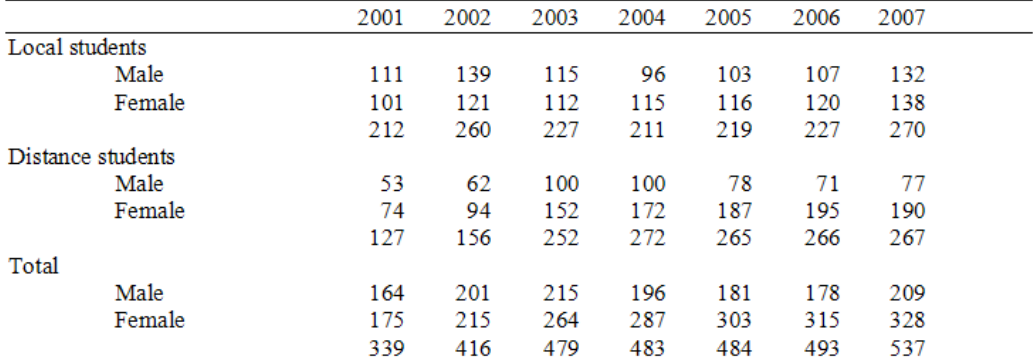
Table 3. Number of students completing Faculty of Business and Science courses